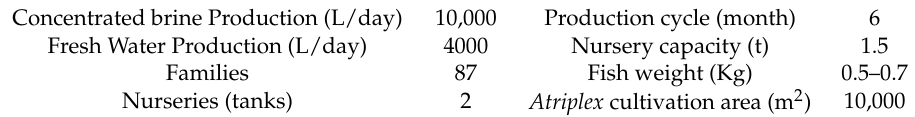
Table 5. Caatinga Grande settlement PAD productive system data for 2018.